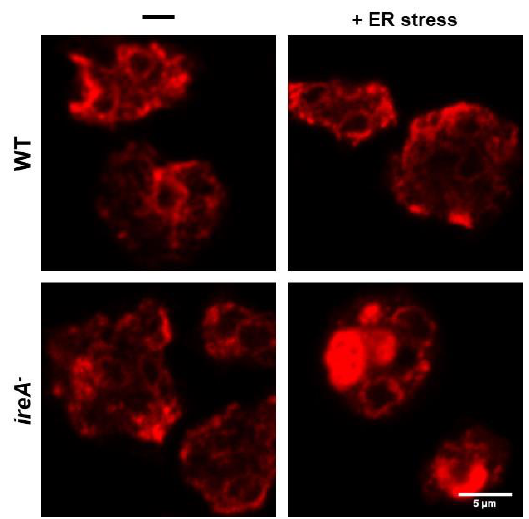
Figure 5. WT and ireA − cells, after an ER stress treatment or mock, were fixed and prepared for the detection of the ER-resident protein disulfide isomerase (PDI) via an immunofluorescence assay and were visualized using confocal microscopy. An ER stress treatment severely impaired the ER morphology of the sensitive ireA − cells. (Scale bar corresponds to 5 µ